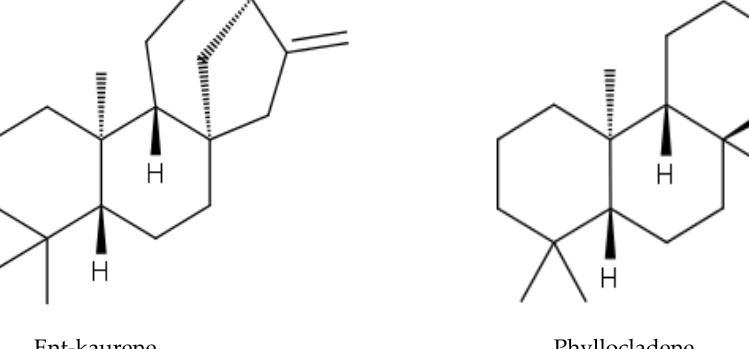
Figure 14. Allelochemicals of Araucaria angustifolia.